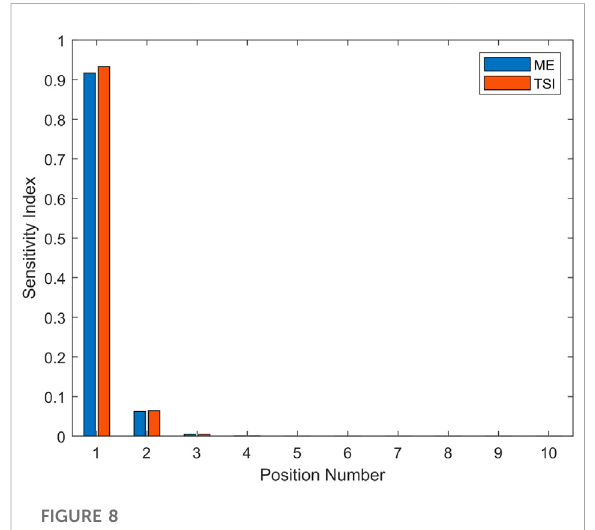
FIGURE 8 Global sensitivity indices of ten inputs corresponding to 10 cells marked by position number to the indicator.